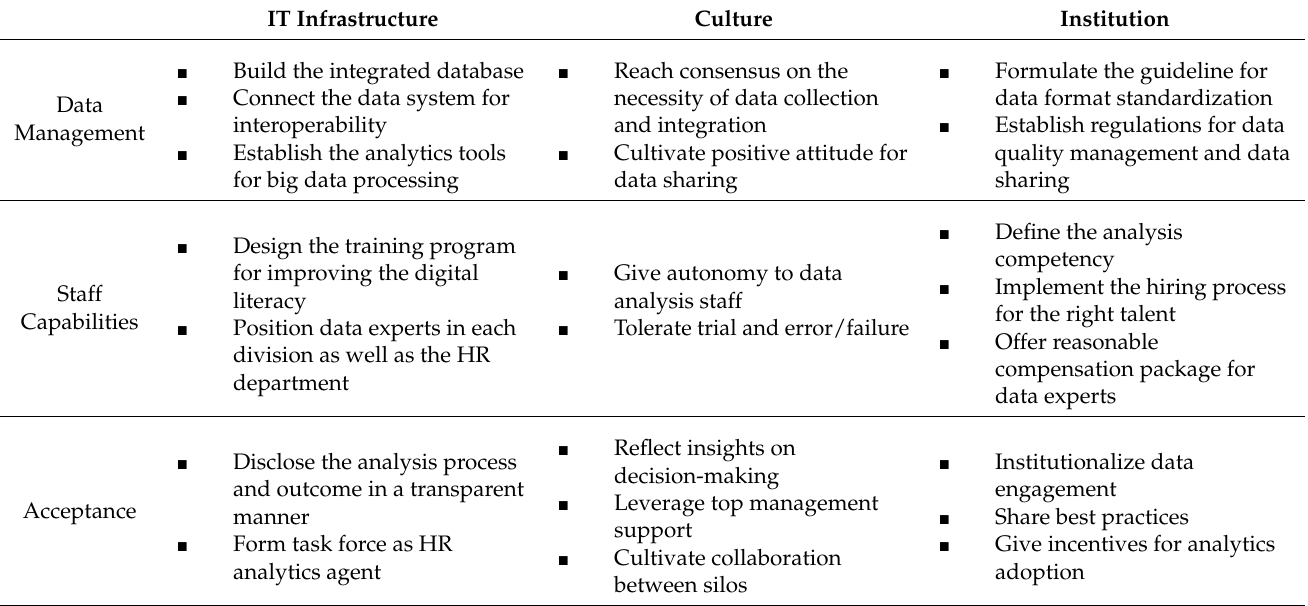
Table 2. Necessary Conditions for the Adoption of HR Analytics by Action